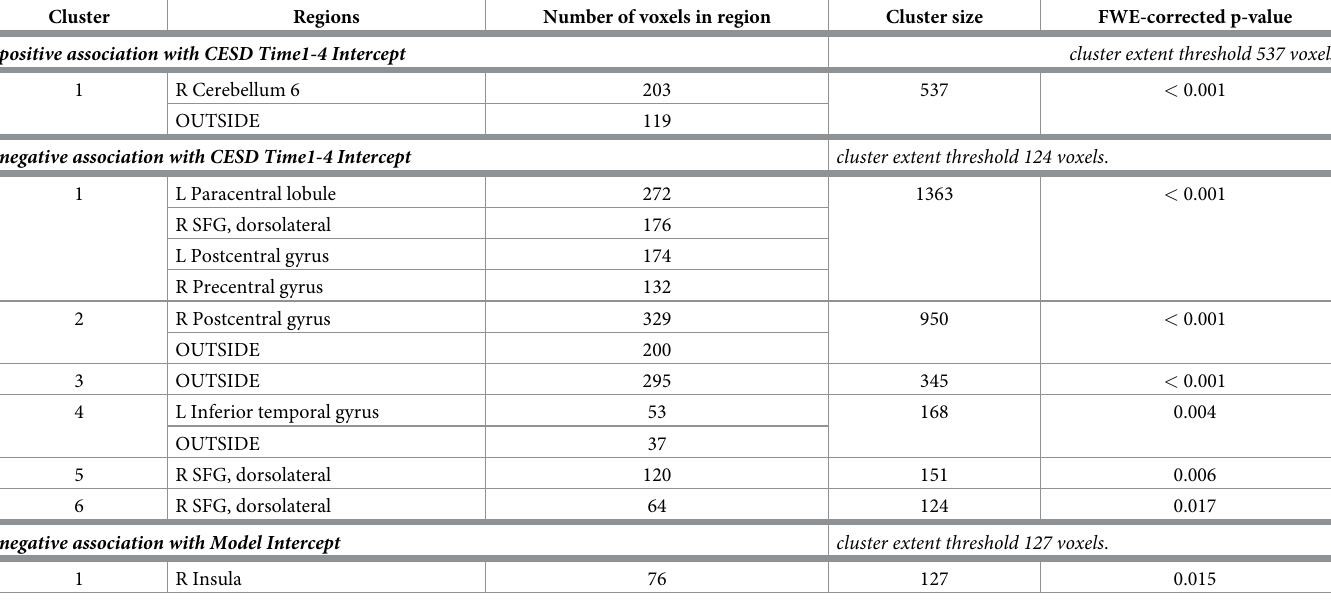
Table 3. Model of estimated future postpartum depression. Brain regions showing differences in maternal activation to own infant in positive versus negative emotion tasks (InfOwnPos > InfOwnNeg) related to increasing postpartum depression symptoms (CESD[T1-4]–estimated postpartum average